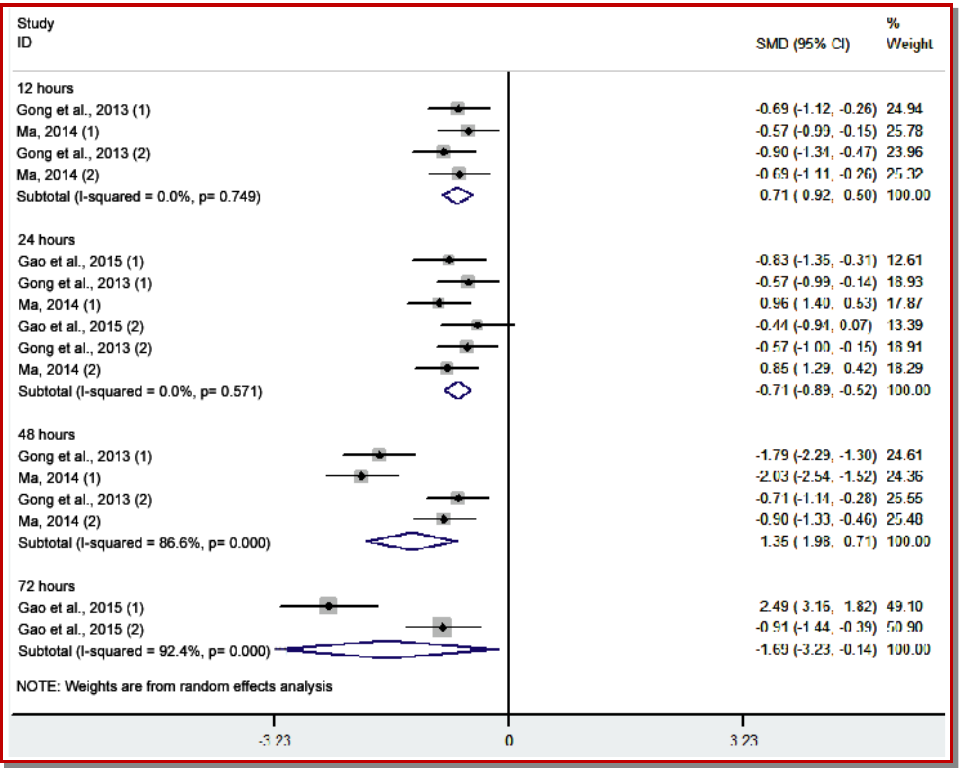
Figure 14: Meta-analysis of β -blocker on the tumor necrosis factor- α (digit within the parenthesis means the number of studies for